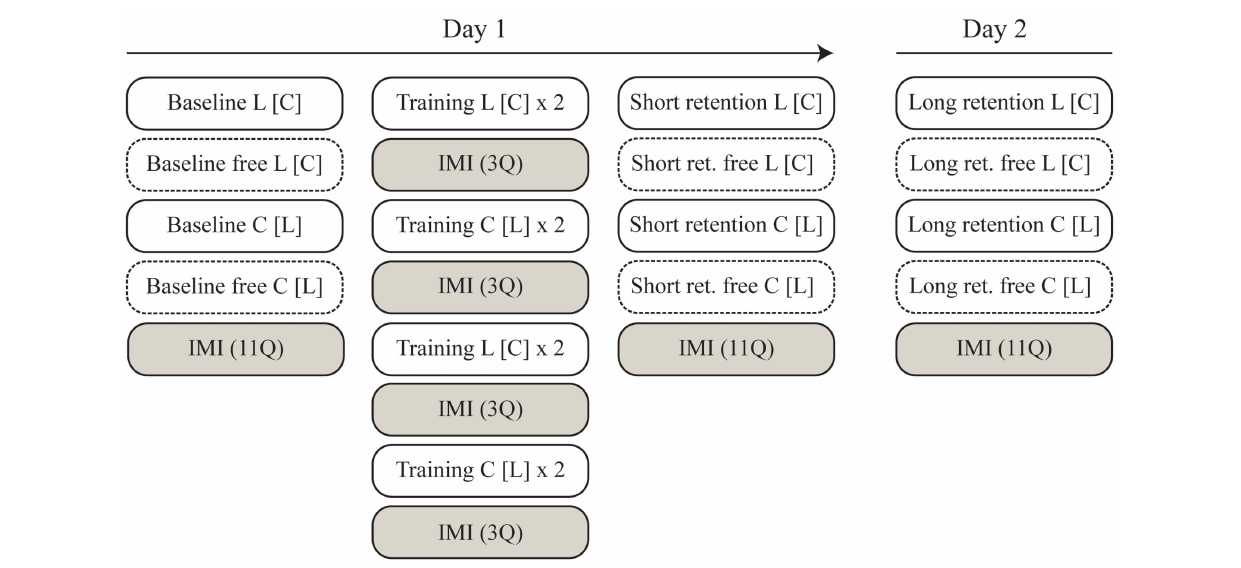
FIGURE 6 | Experimental protocol . On day 1, subjects started with a baseline test (1min) where they were instructed to track the dispenser that followed the line (L) or the circle (C), depending on the order of the task. During baseline free (1min), subjects were asked to reproduce the movement without visual feedback (dashed blocks). Baseline and baseline free were then repeated for the second task. During the training blocks, subjects trained with no haptics, mixed guidance, HG + EA, or random disturbing forces, depending on their training group, in eight blocks of 1.5min each. The order of the tasks to be trained was alternated. First, subjects performed two training blocks with the first task, followed by two blocks with the second task. These four blocks were then repeated again. After a 5-min break, short-term retention and short-term retention free tests per each task were performed that followed the same structure and order than the baseline and baseline free tests. After 3–5days subjects came back to perform the long-term retention and long-term retention free tests. After the second baseline free test, and at the end of both experimental days, subjects responded to 11 questions selected from the Intrinsic Motivation Inventory (IMI). Subjects also responded to the first three questions of the questionnaire after every two training